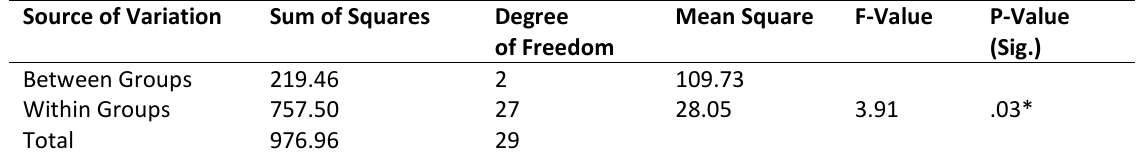
Mean Square of Freedom